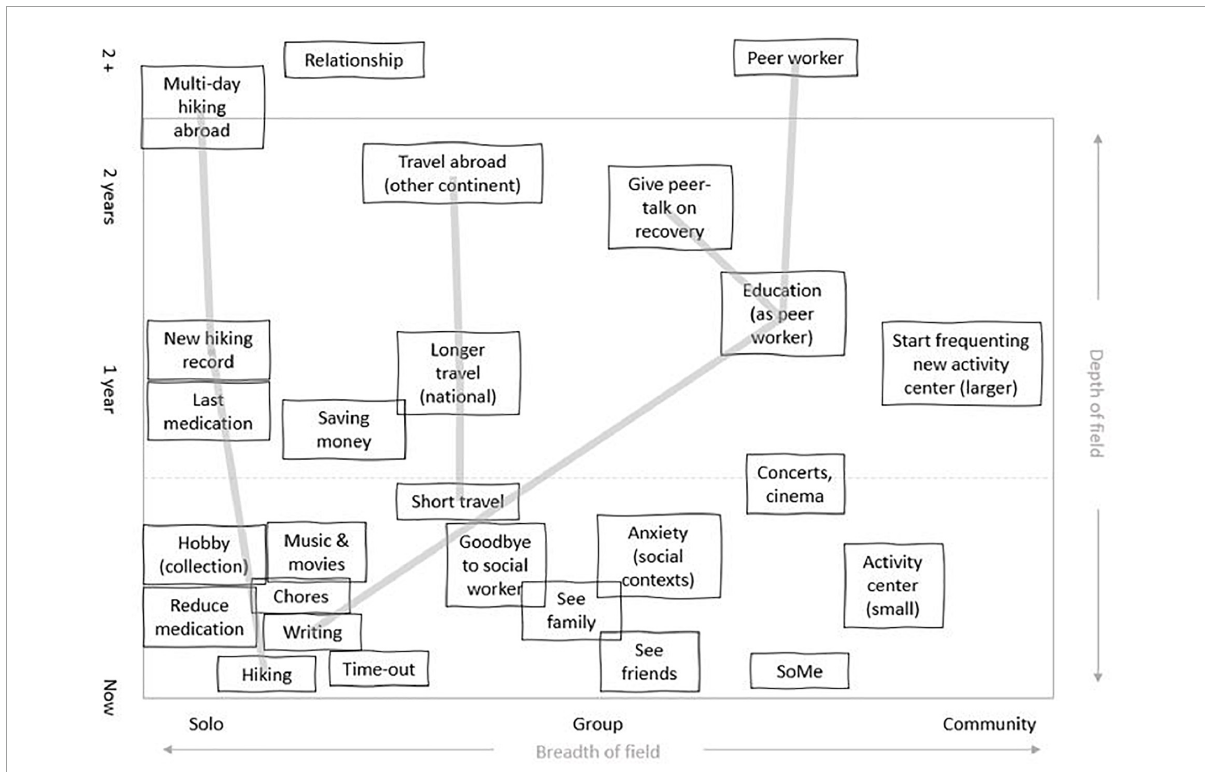
FIGURE4 This field of relevant offordances from a 31-year-old male diagnosed with paranoid schizophrenia shows the affordances present for one informant when considering both the present and possible future occurrences. The gray lines show examples of congruence between present activities and future plans, e.g., keeping diary/blog about recovery education as peer worker, talks and job